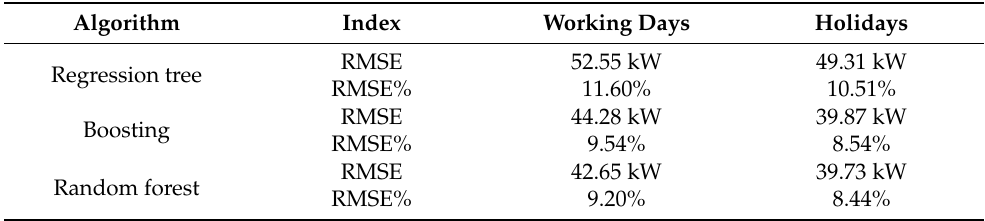
Table 2. Error comparison between working days and